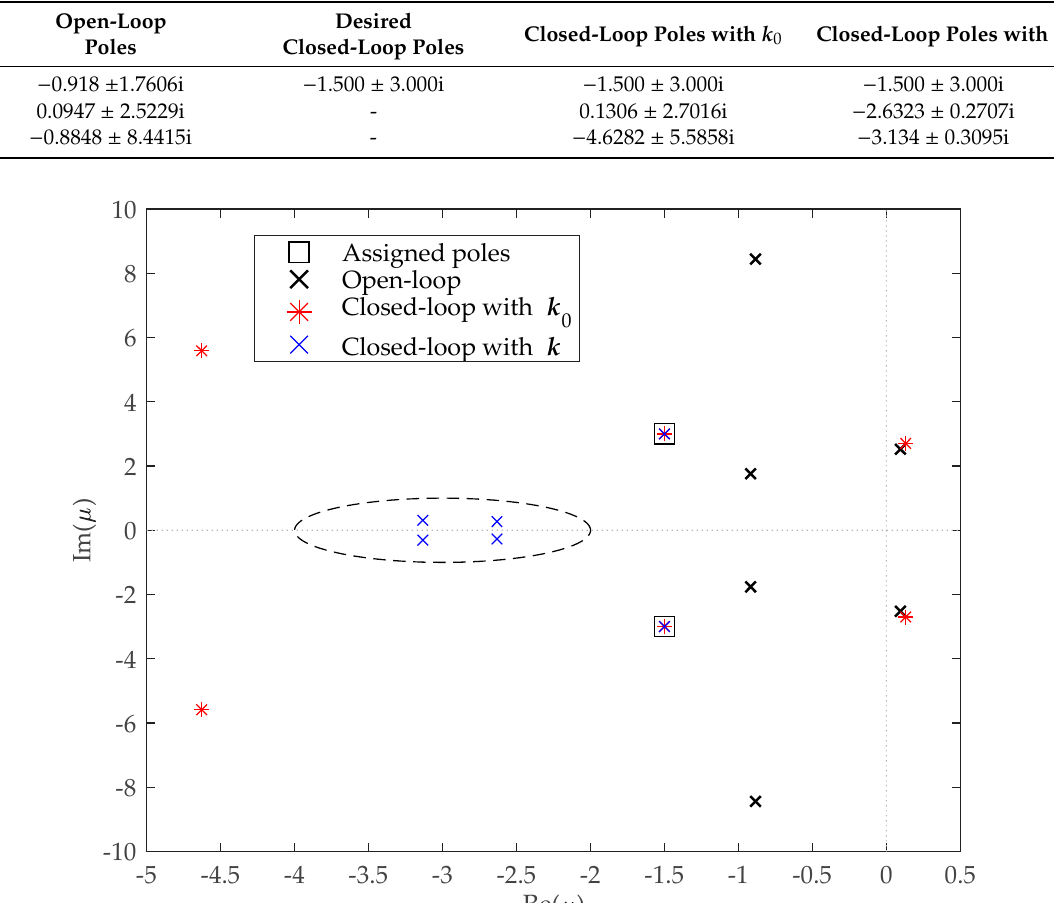
Table 7. Open-loop and closed-loop poles (test-case 3).